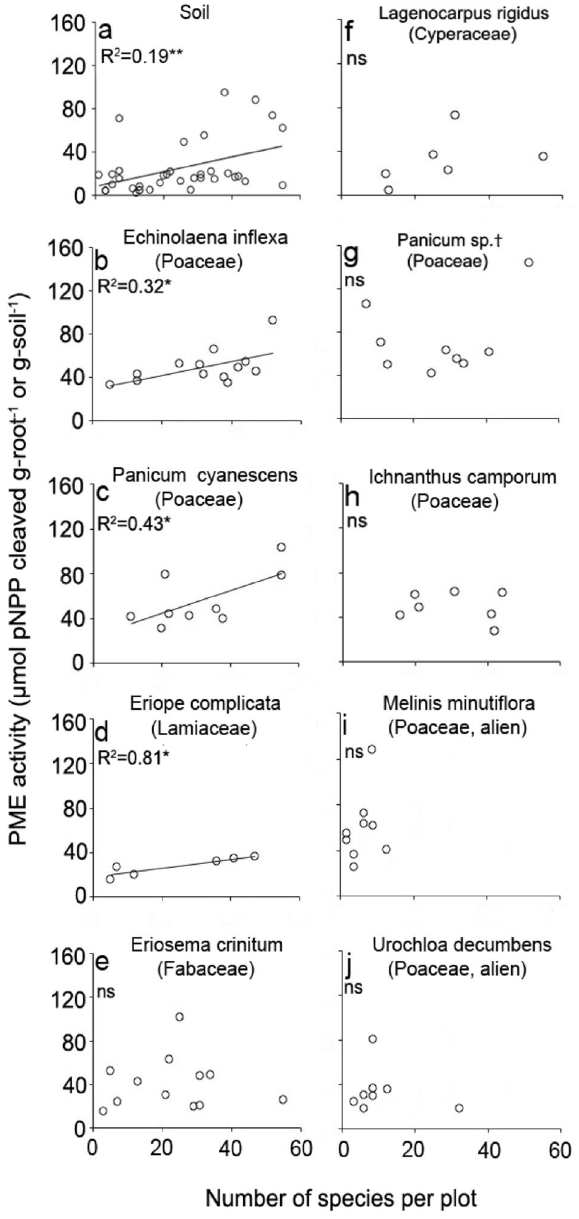
Figure 2. Root phosphatase (PME) activity of common Cerrado plant species, as well as soil PME activity, in relation to species richness of the plant community. ( a ) PME activity in the soil, and ( b )–( i ), root PME activity Root and soil samples were collected in 38 sites in the Brazilian Cerrado (five nature reserves in two regions, see Suppl. Figure 1). Only significant ( p < 0.05) regressions are drawn. †Could not be identified to species